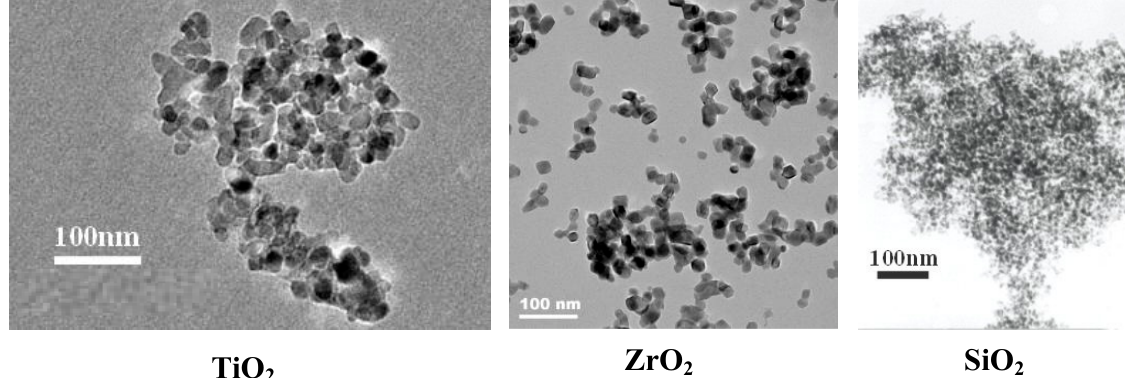
Figure 1. TEM images of nanoparticles [29].